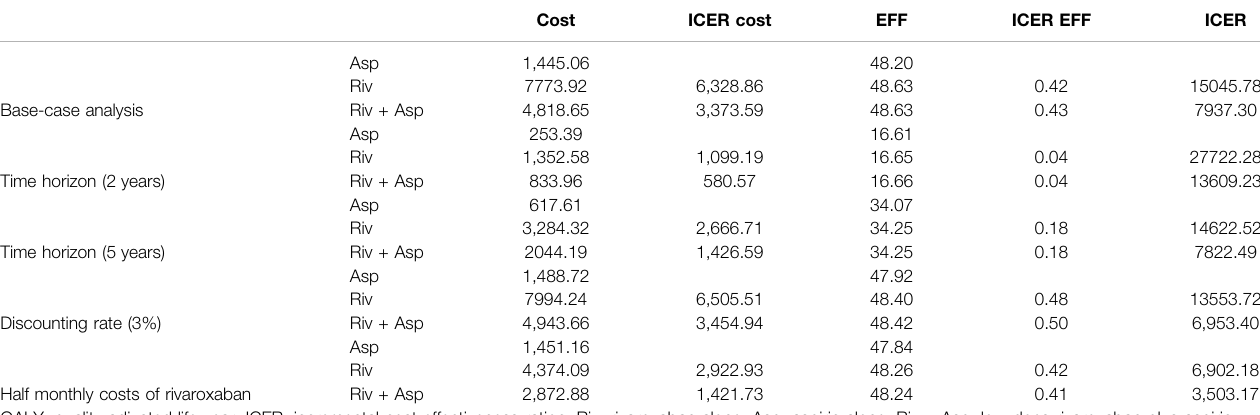
TABLE 4 | The result of base-case cost-effectiveness analysis and scenario sensitivity analyses.